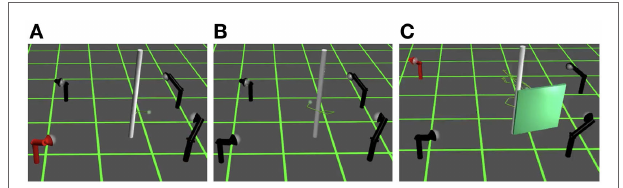
FigUre 9 | (a) The red lamp-bot is highlighted in red as it is currently selected, ready for reconfiguration. (B) The plant-like structure grows around the pole as it is alternately attracted by one of the lamp-bots. (c) A panel has been placed to shield the plant physically from one light source.